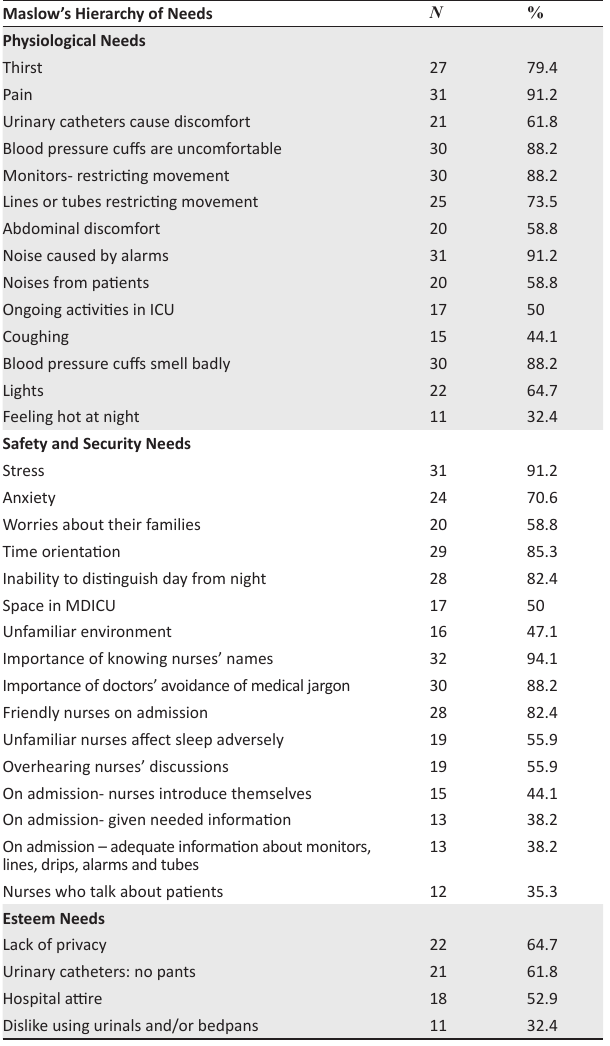
TABLE1: Factors influencing patients’ sleep deprivation in a multi-disciplinary intensive care. Maslow’s Hierarchy of Needs N